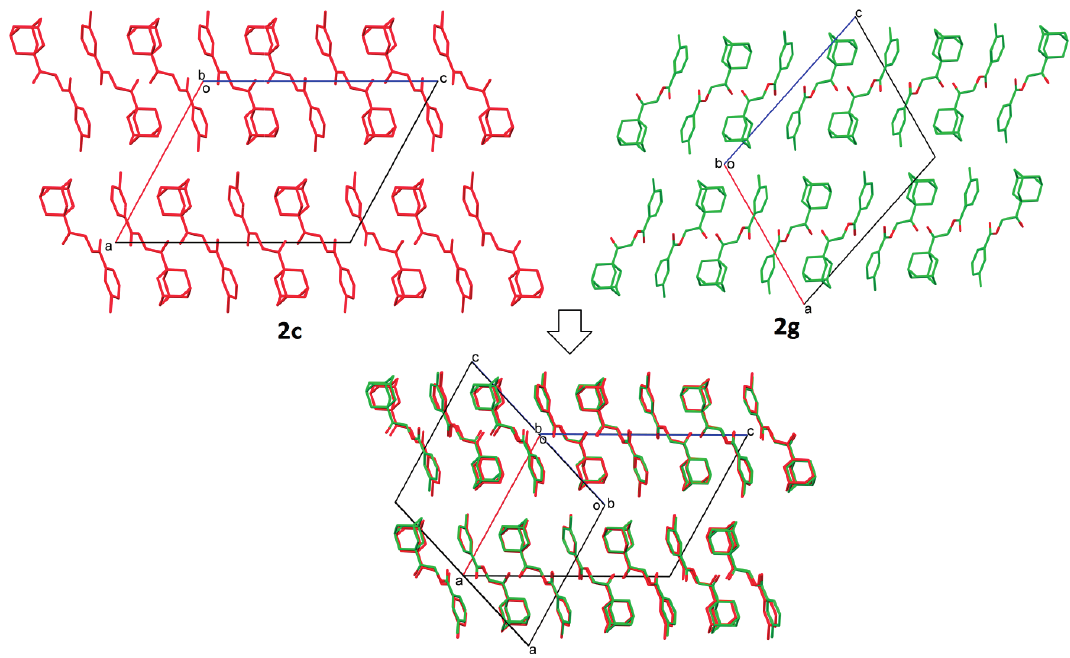
Figure 4. Crystal packing comparison of Compounds 2c and 2g